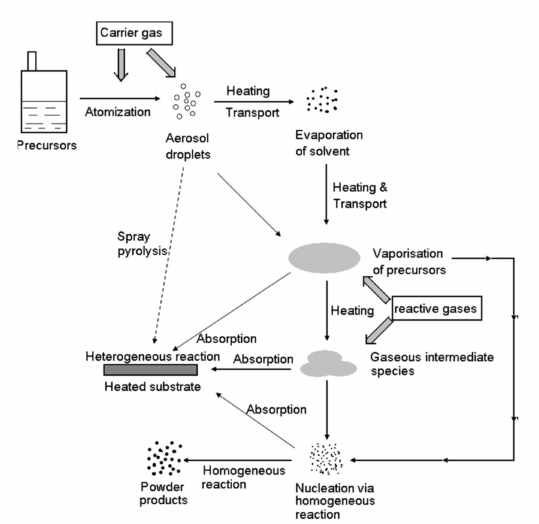
Figure 1. General scheme of Chemical Vapour Deposition (CVD) assisted by aerosol. Once atomized, the droplet loses the solvent (if present) and the precursor di ff uses to the heated substrate, where it is chemisorbed, giving origin to the coating (heterogeneous reaction). In a parallel path the precursor reacts through homogeneous reactions in the gas phase, then species adsorb onto the substrate, or through an extensive reaction in the gas phase, to form powder products. Reprinted with permission from [7]. Copyright 2006 John Wiley & Sons,